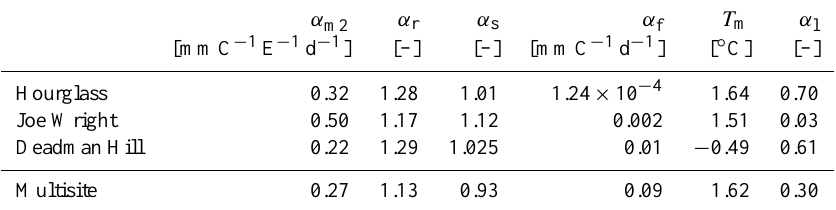
Table 3. Optimal parameter values estimated for each of the three SNOTEL stations for the C2 model at a daily time step. E is in Wm − 2